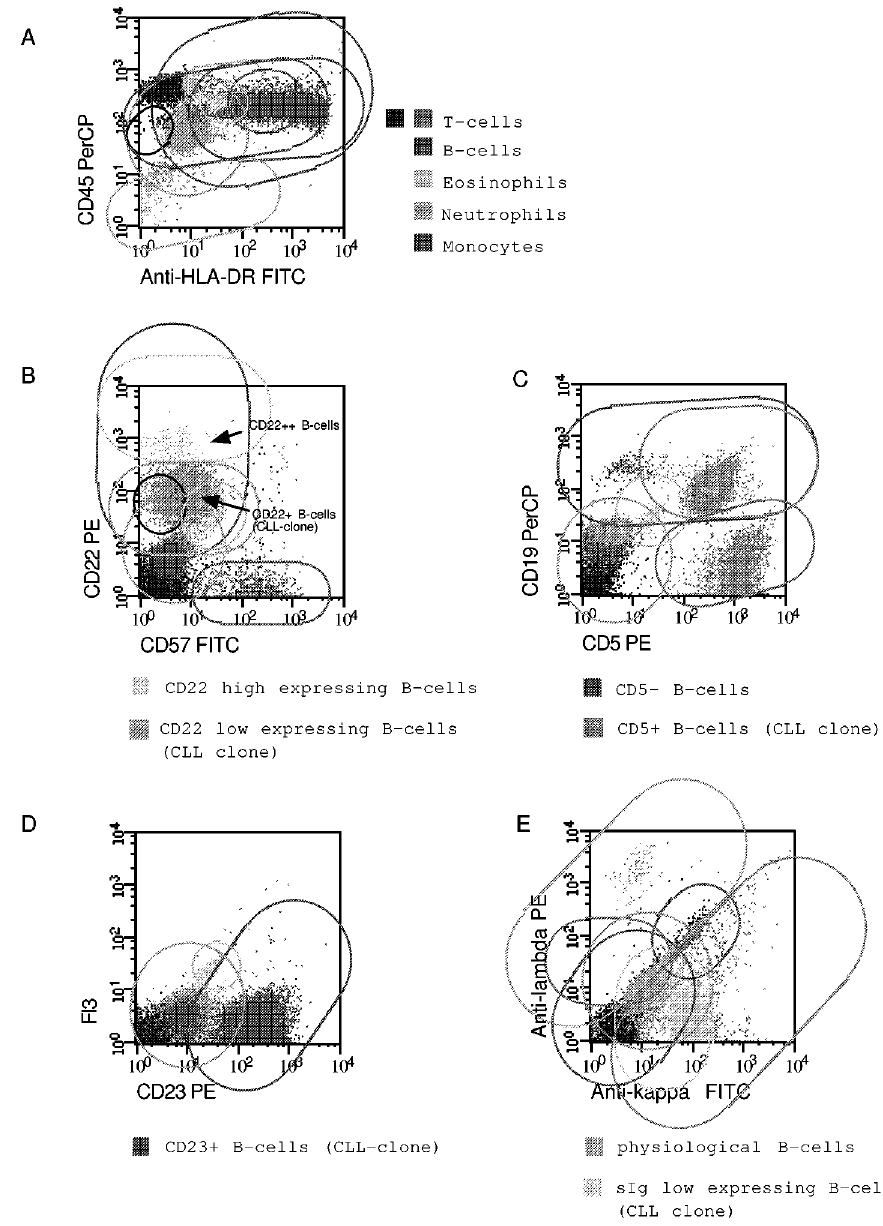
Fig. 3. Various attractors define regions of characteristic antigen coexpression patterns or fluorescence intensities, especially of B-cell popula- tions. Classified cell populations are displayed by different colors and the B-CLL clone presents as a CD45 + /HLA-DR + /CD22weak/CD19 + / CD5 + /CD23 + /sIg weak cell population, that can be separated in B, C and E from the remaining physiological B-cell